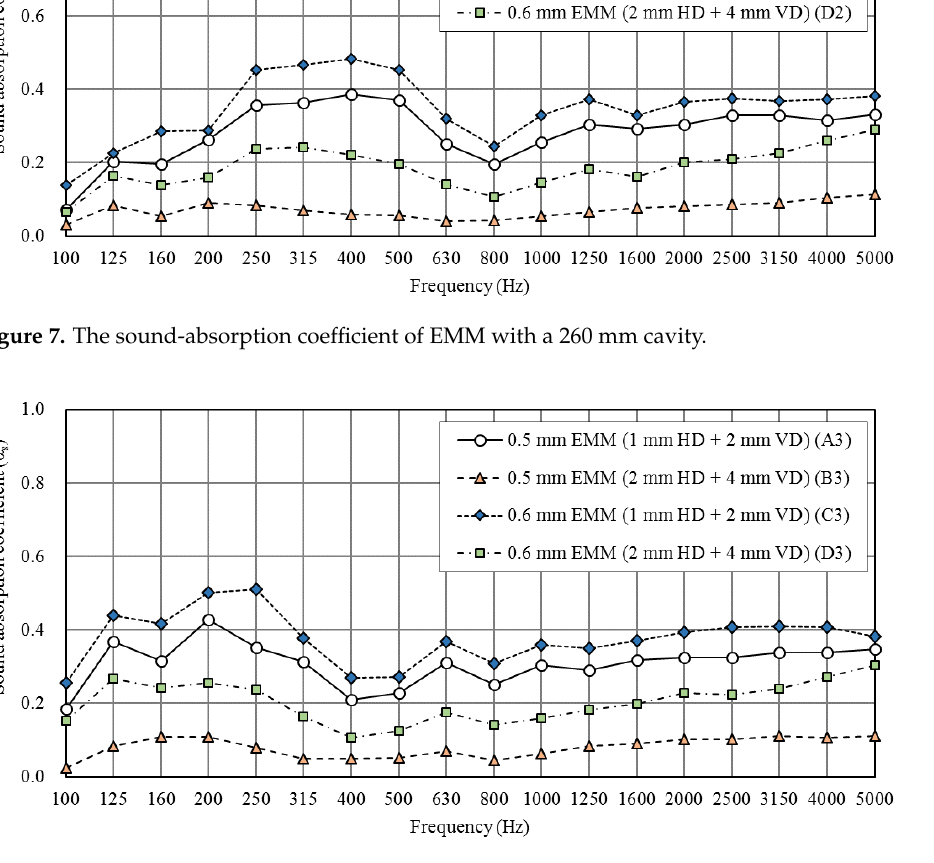
Table 2. The specimen setting and measurement results of folded expanded metal mesh (FEMM).